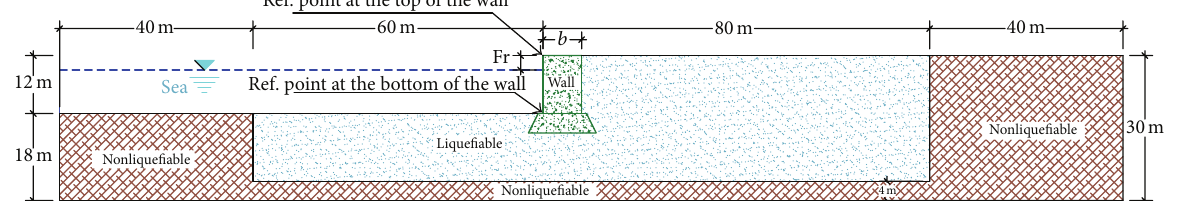
Figure 1: Overall geometry of the gravity quay wall (dimensions in meter, NTS), Fr and b =